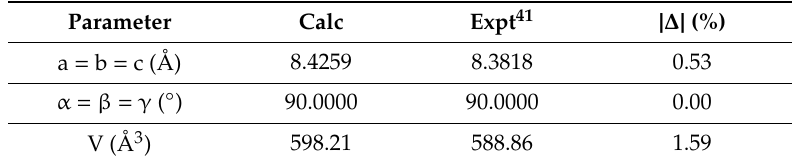
Table 1. Comparison between the experimental and calculated structural parameters of cubic Mg 6 MnO 8